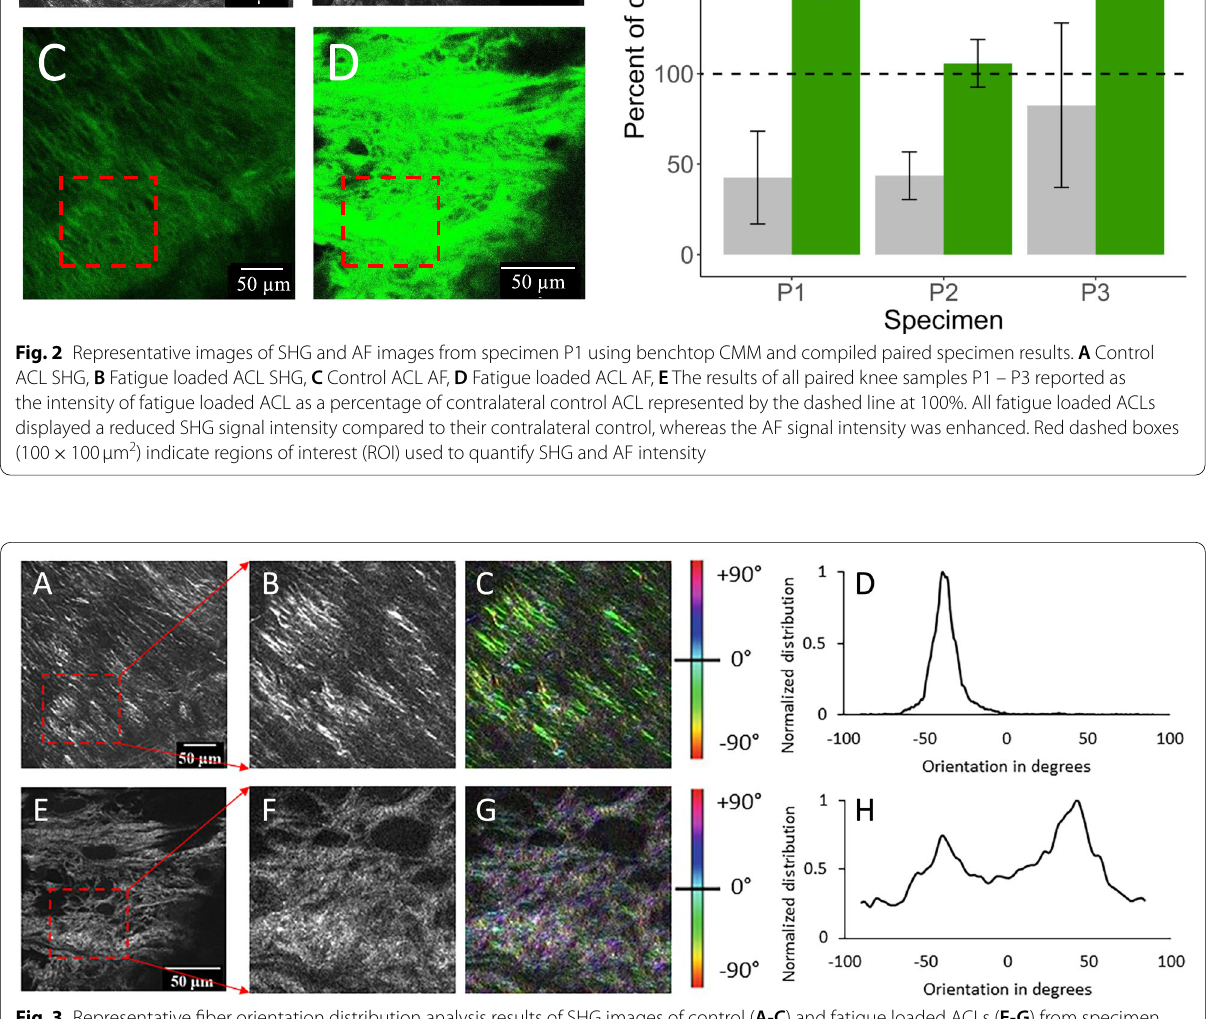
Fig. 3 Representative fiber orientation distribution analysis results of SHG images of control ( A-C ) and fatigue loaded ACLs ( E-G ) from specimen P1. A SHG image of a control ACL, with the cropped ROI shown in B ; C Color‑coded SHG image showing orientation map of fibers; D Normalized distribution of orientation with a narrow peak with FWHM of 15°; E SHG image of a fatigue loaded ACL with the cropped ROI shown in F ; G Color‑coded SHG images showing orientation map of fibers; H Normalized distribution of orientation displays a dispersed bimodal distribution with a FWHM of